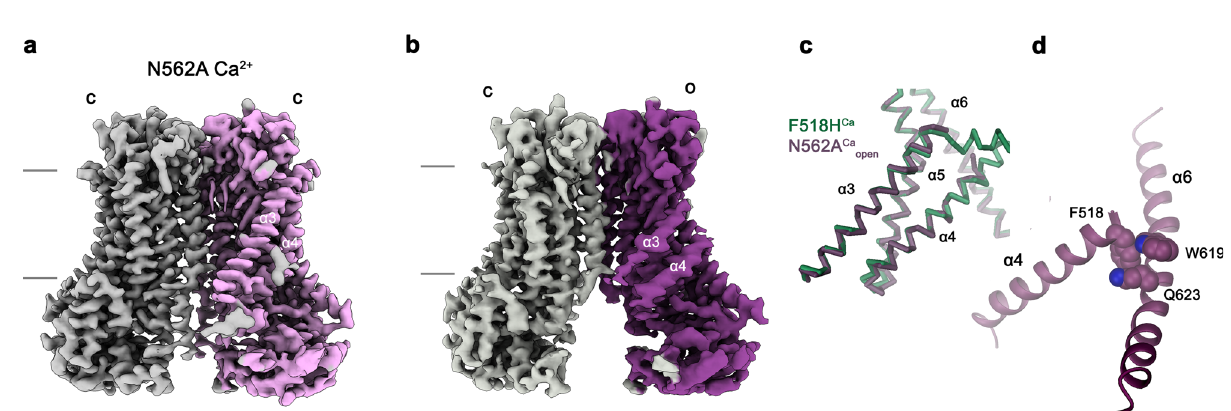
Fig. 6 | Features of the activating mutant N562A. Cryo-EM densities of the symmetriccloseddimerofN562A Ca at3.01Å( a )andtheasymmetricdimerat3.49Å withtheactivatedsubunitshownincolor( b ).Subunitconformationsareindicated asclosed(c)andopen(o). c ComparisonoftheopenconformationofN562A Ca